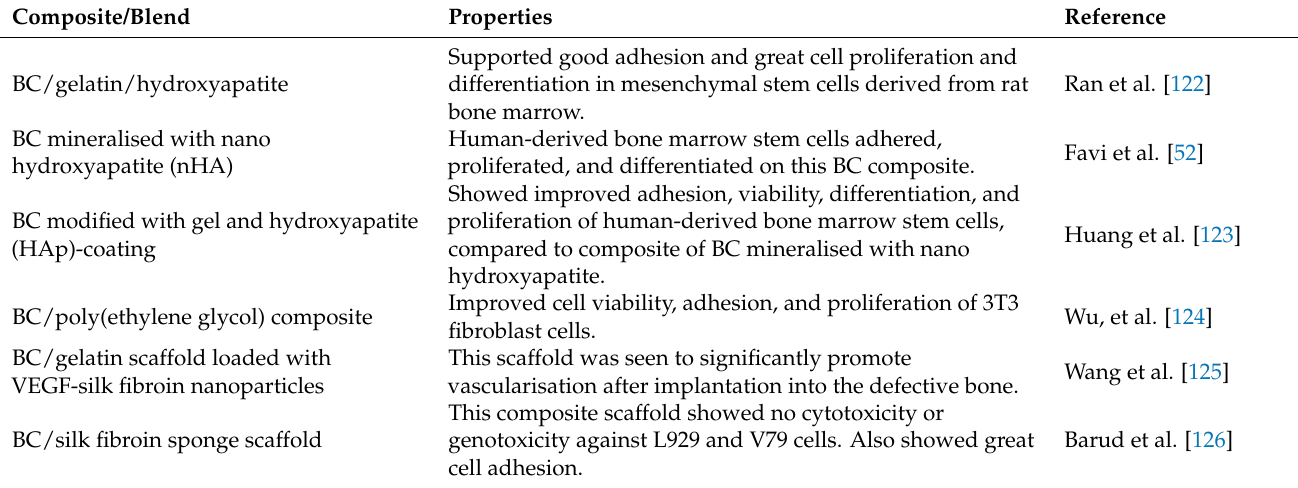
Figure 5. SEM images of the morphology of HAp-BC composites, produced for bone tissue engineer- ing. ( a ) control (pure BC) at × 10,000 magnification, ( b ) HAp-BC composites at × 10,000 magnification, and ( c ) HAp-BC composites at × 5000 magnification (adapted from Bayir et al. [121]). Table 1. Examples of potential BC composites and blends tested for bone tissue